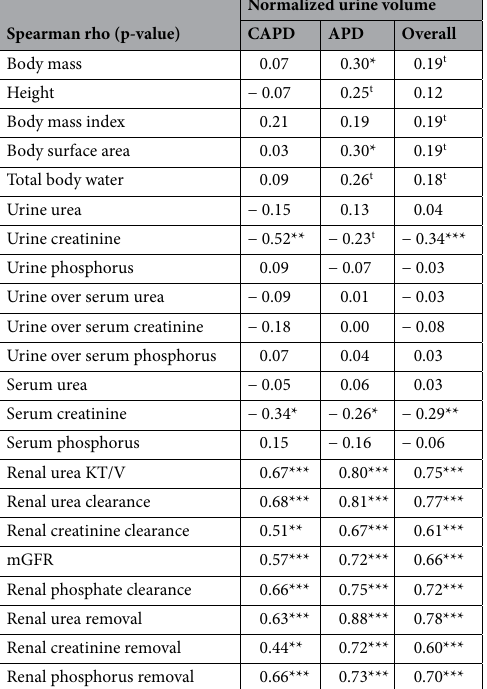
Table 4. Correlations between normalized urine volume and other parameters in patients on continuous ambulatory (CAPD), automated peritoneal dialysis (APD) and for pooled data. ***, **, *, t denote p value < 0.001, < 0.01, < 0.05 and < 0.10,